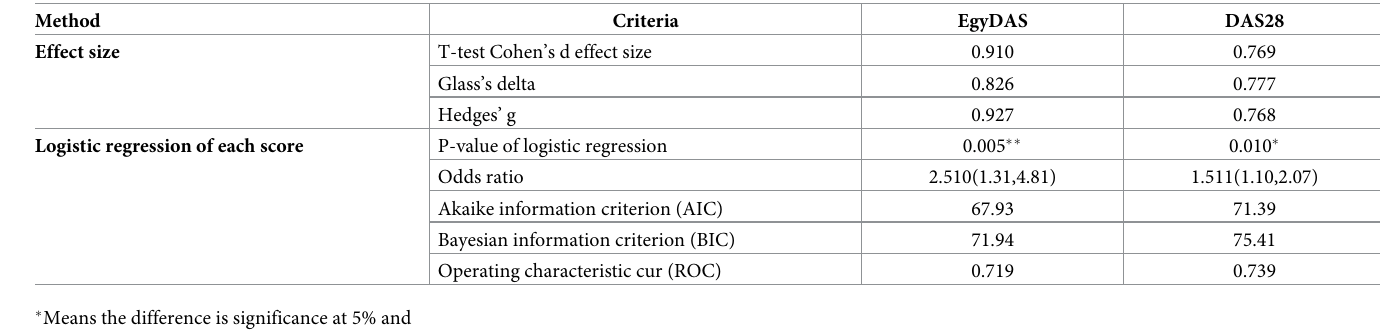
Table 4. Several criteria to evaluate the ability of the disease scores (EgyDAS and DAS28) of differentiating between the two study groups (patients with ankle involvement and patients without).